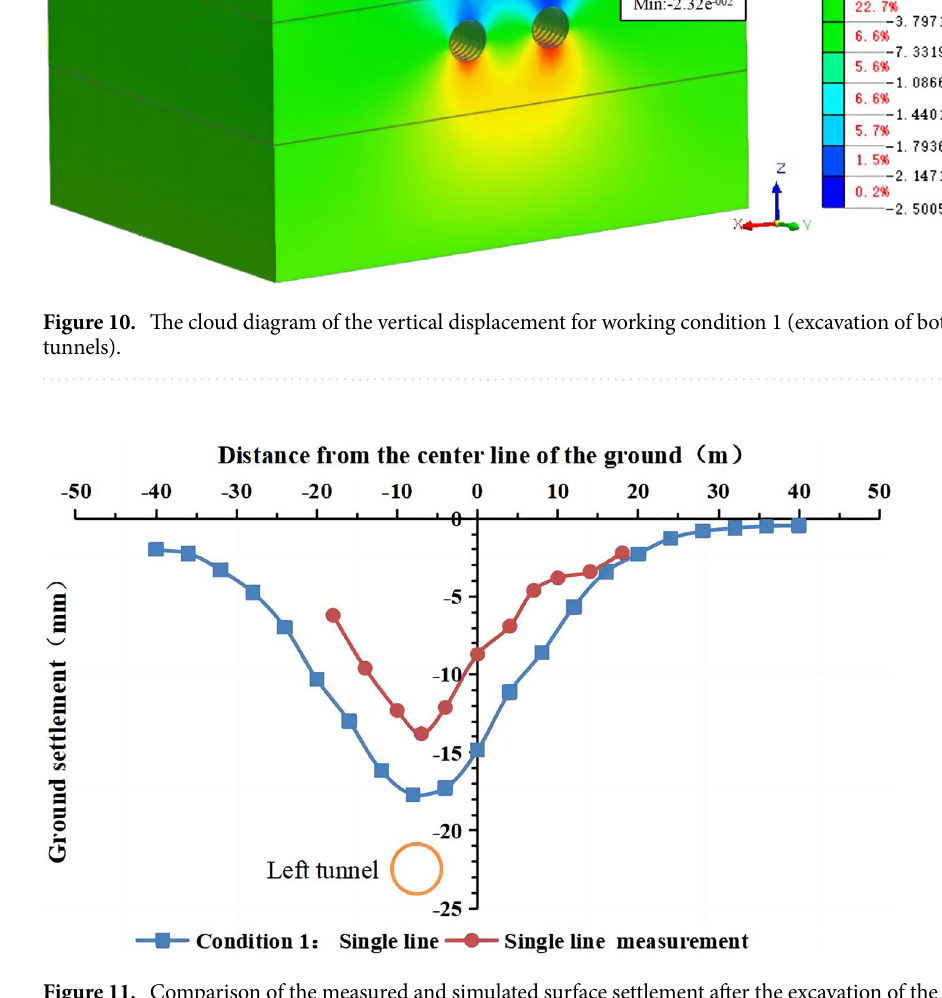
Figure 11. Comparison of the measured and simulated surface settlement after the excavation of the left